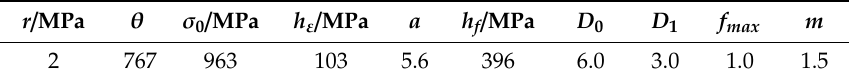
Table 1. Data from the published research [17].